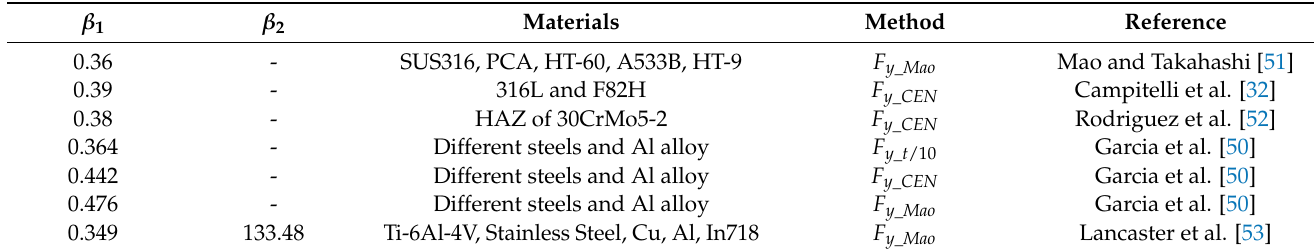
Table 7. Recommended values of parameters β 1 and β 2 in different